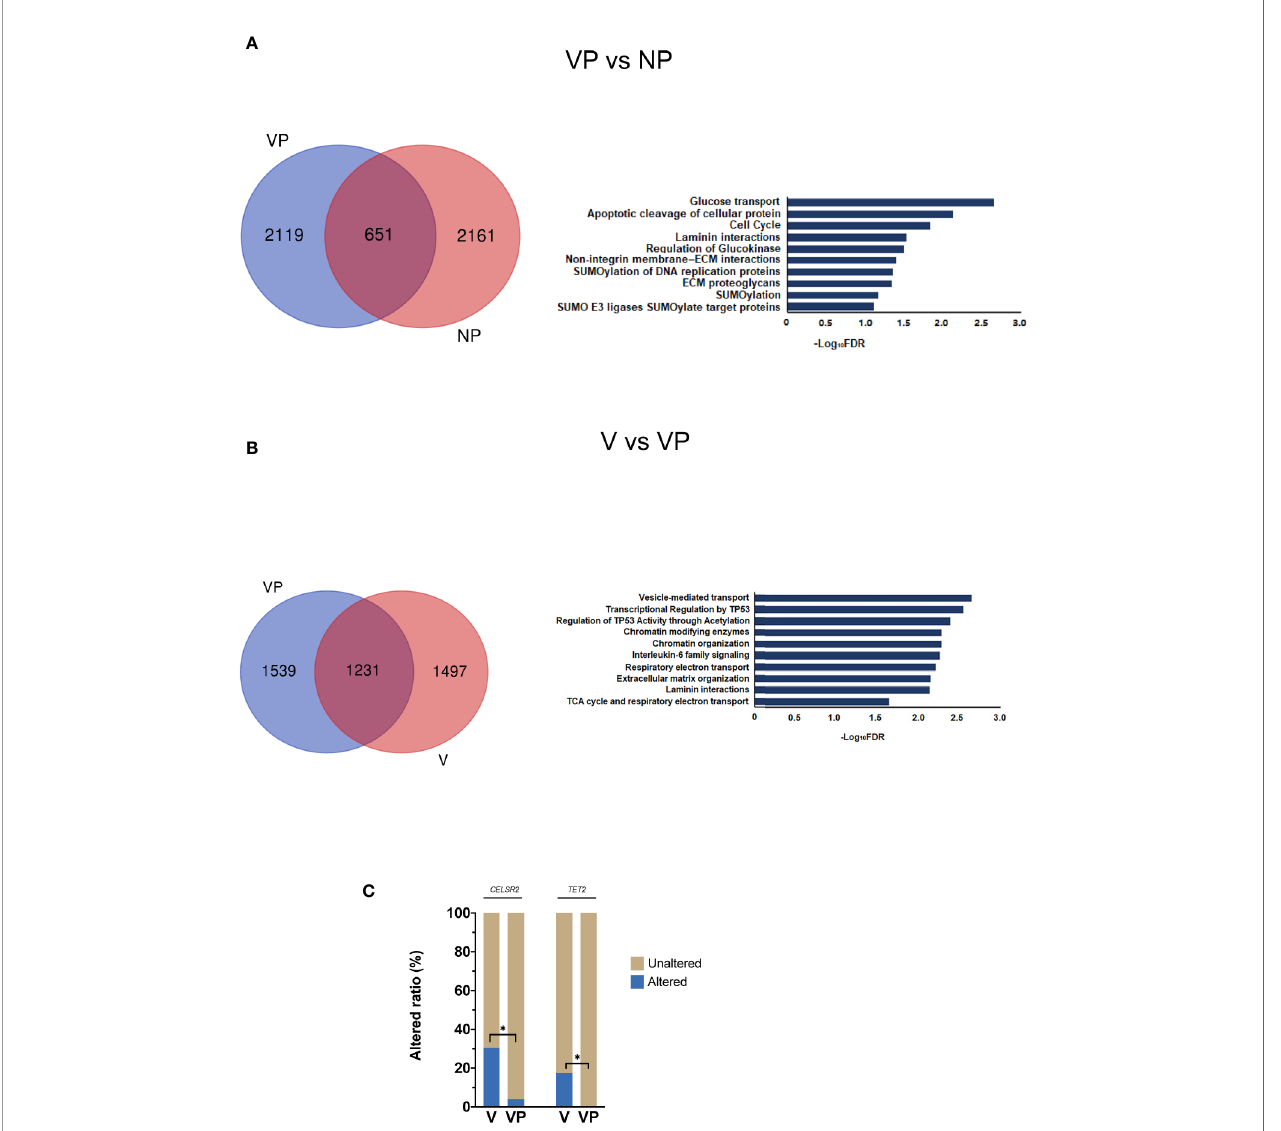
FIGURE 2 | Analysis of differences in mutant gene prevalence. (A) Venn diagram and reactome pathway analysis of the differentially mutated genes in the VP and NP groups. (B) Venn diagram and reactome pathway analysis of the differentially mutated genes in the V and VP groups. (C) Differences in CELSR2 and TET2 mutational prevalence between the V and VP groups. * p < 0.05. VTT, venous tumor thrombus; V, VTT; VP, matched primary tumor; NP, normal primary tumors without